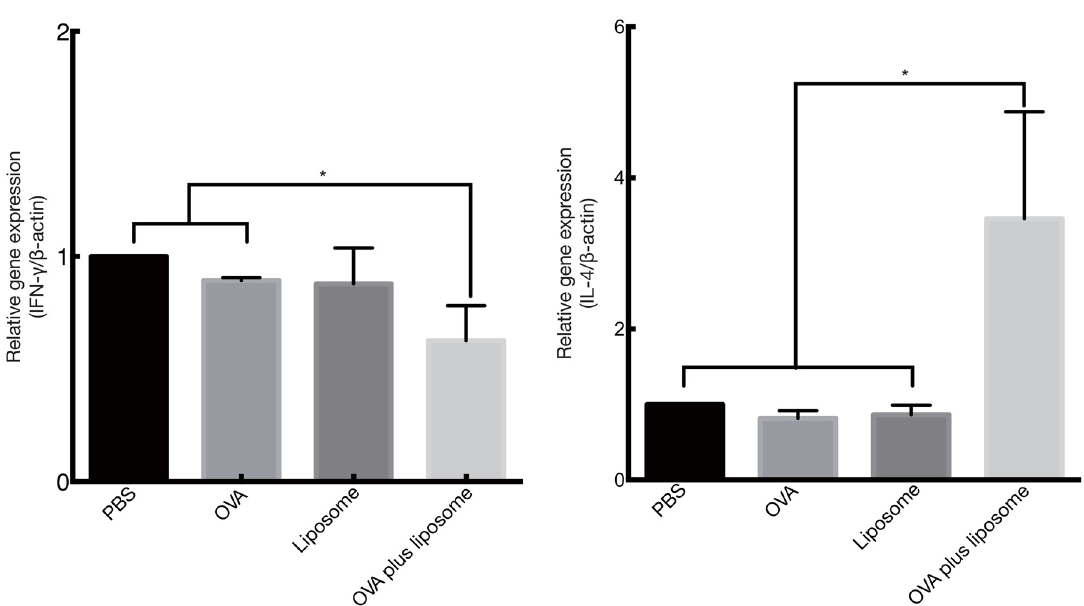
Fig 9. mRNA levels of Th1/Th2 cytokines in vaccinated mice. One hour after the last immunization, spleen and nasal tissues were collected and the expression of mRNAs was quantified by semi-quantitative RT-PCR. Densitometry values for mRNA were normalized to β -actin as an internal standard. The data were representative of at least three independent experiments and are expressed as the mean ± standard deviation for samples assayed in triplicate. Significant difference was assessed using t -test with Welch correction: * p <